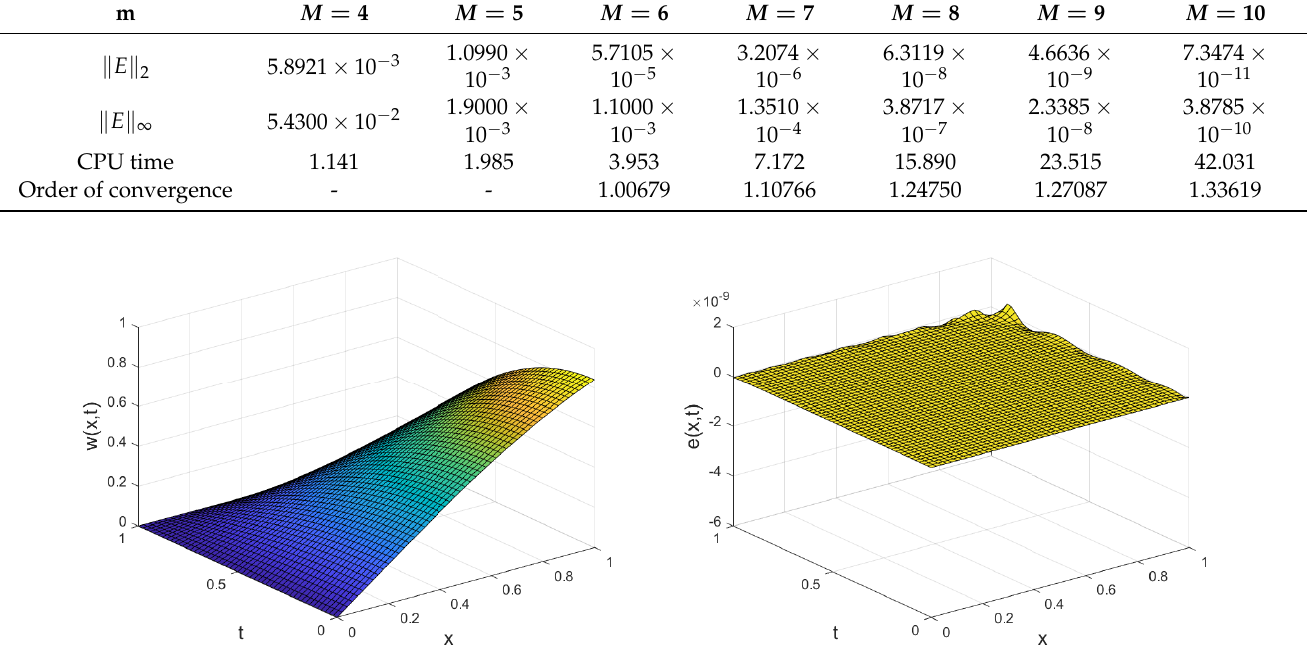
Figure 1. Plot of the approximate solution and absolute value of the error for Example